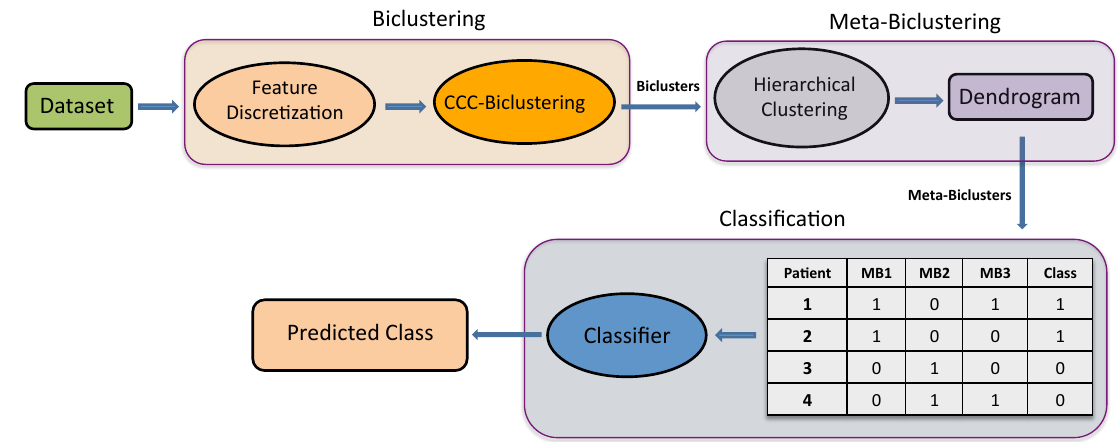
Figure 1: Workflow of a classifier based on